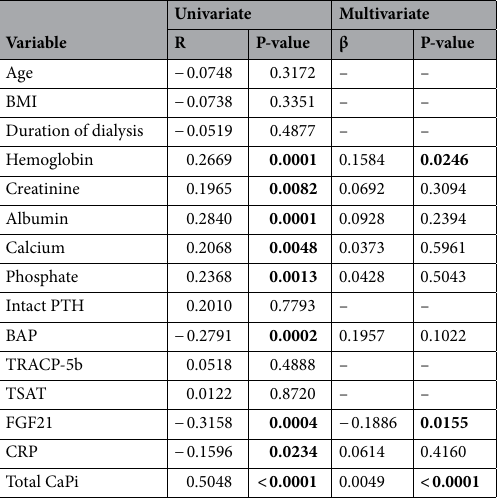
Table 5. Univariate and multivariate analysis between amorphous CaPi ratios and serum parameters in the hemodialysis patients. Significant values are in